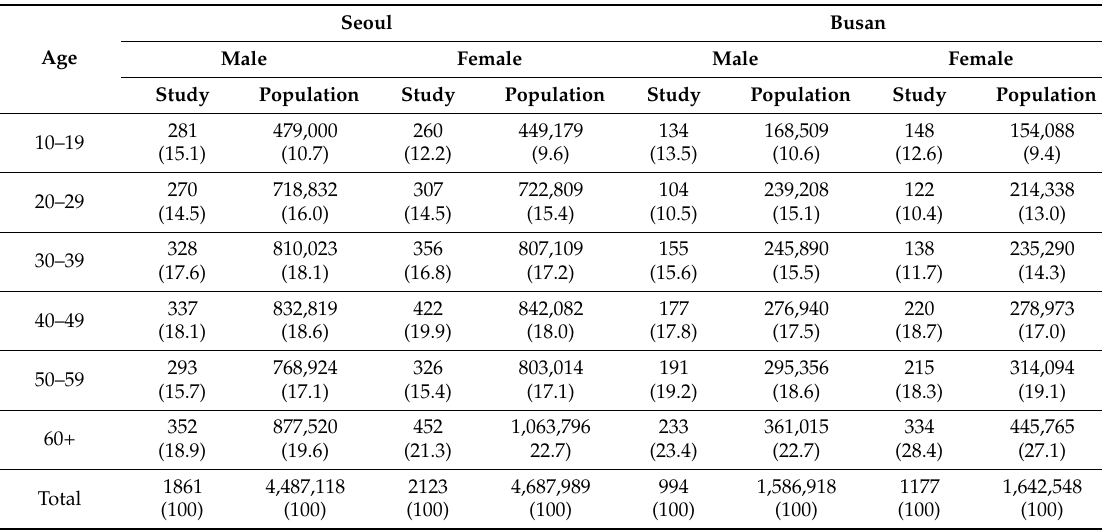
Table 1. Gender and age characteristics of Seoul and Busan between study participants and original